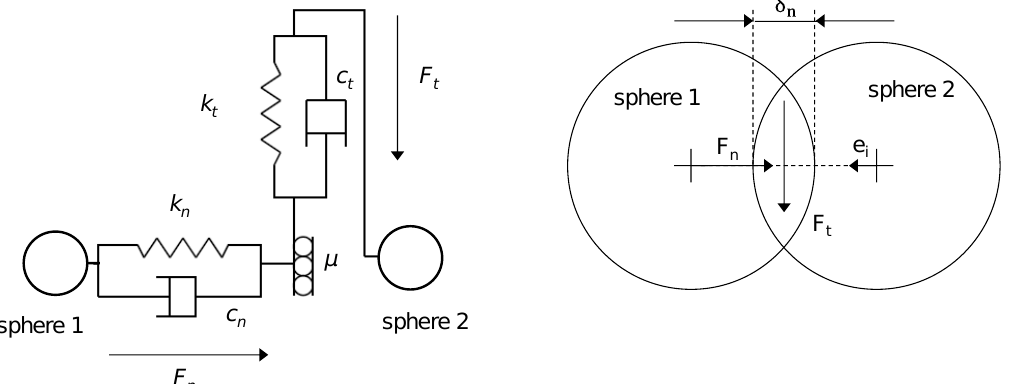
Figure 4. Representation of the spring-damper system ( left ) based on the contact of two spheres ( right ) in the DEM.